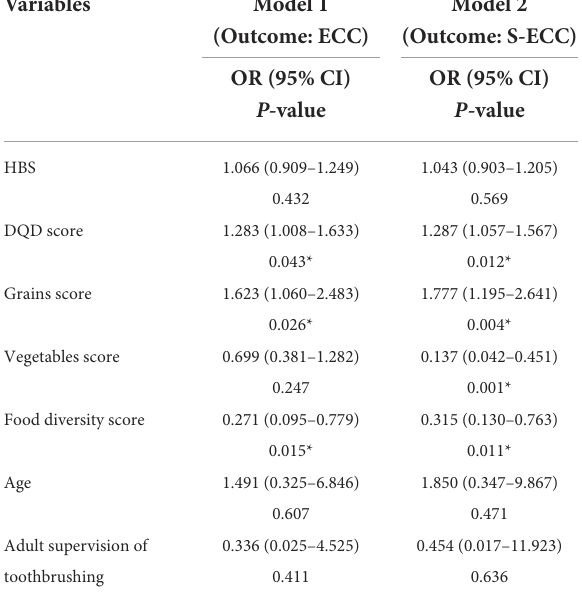
TABLE 2 Multivariable logistic regression analysis for the associated factor of ECC and S-ECC.